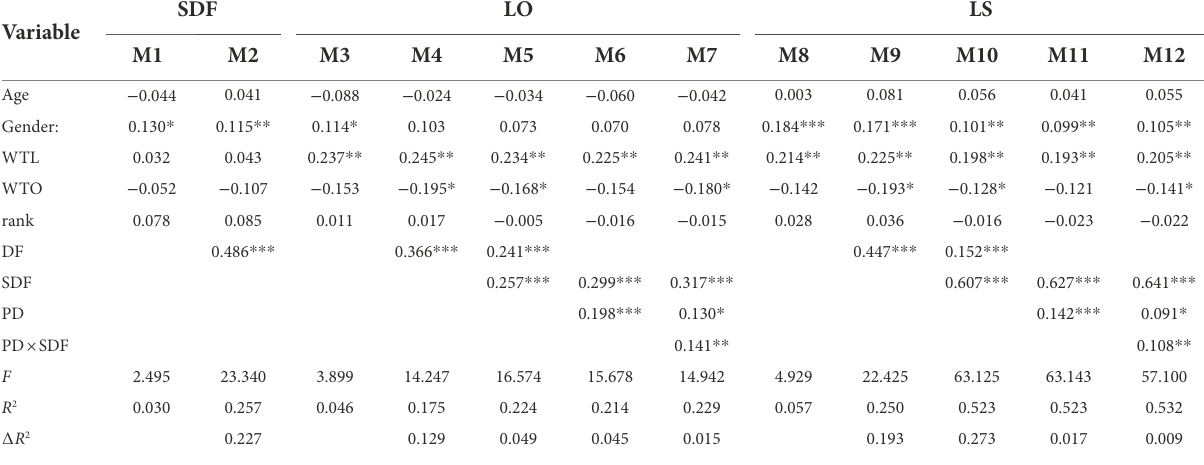
TABLE 3 Results of hierarchical regression